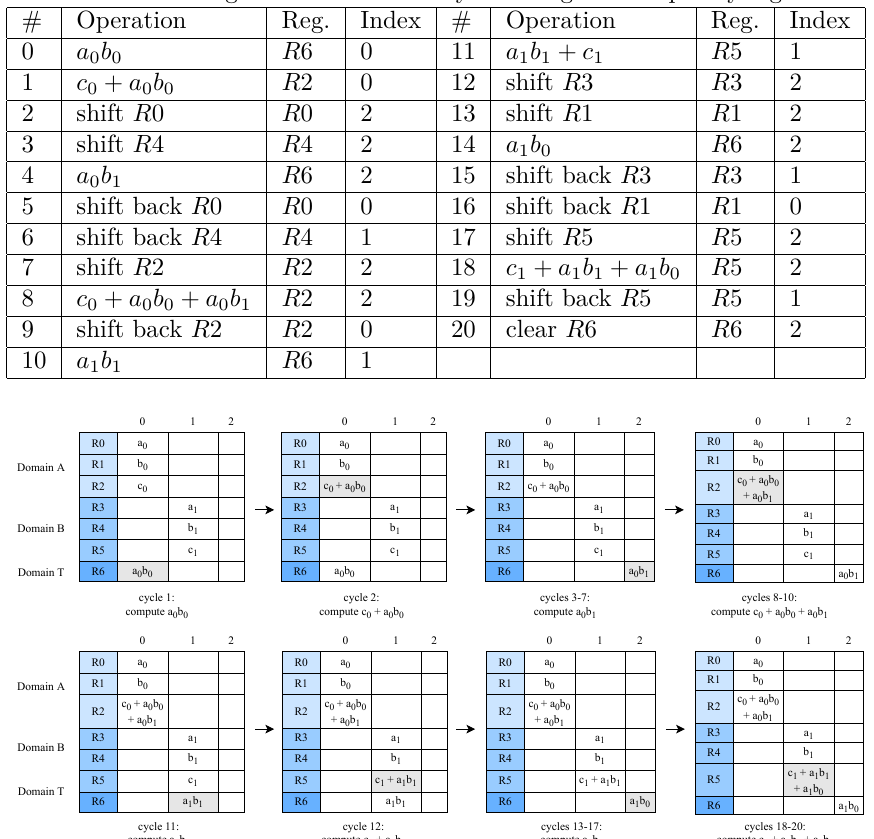
Table 1: Toffoli gate executed in 21 cycles using one temporary register.